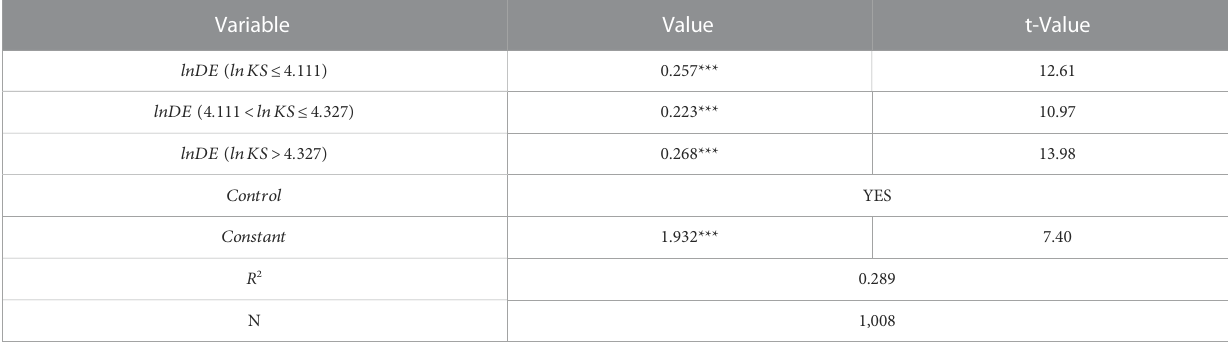
TABLE 12 Robustness tests for the threshold regression